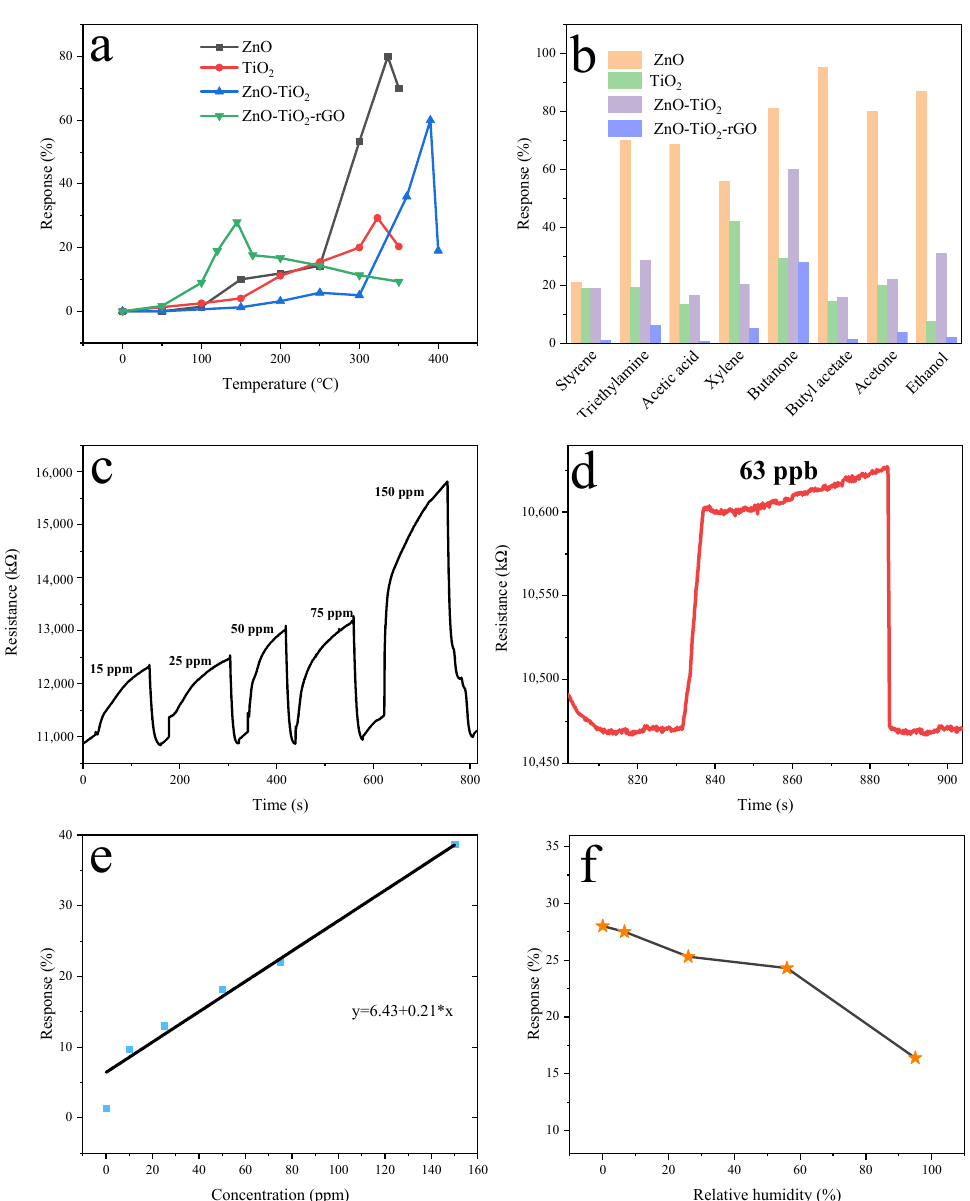
Figure 8. ( a ) Optimal operating temperatures for ZnO, TiO 2 , ZnO-TiO 2 , and ZnO-TiO 2 -rGO sensors. ( b ) Response of ZnO, TiO 2 , ZnO-TiO 2 , and ZnO-TiO 2 -rGO sensors to different gases at 100 ppm. ( c ) ZnO-TiO 2 -rGO sensor response versus butanone concentration. ( d ) Minimum lower limit of ZnO-TiO 2 -rGO sensor. ( e ) The sensitivity-fitting curves of ZnO-TiO 2 -rGO for different concentrations of butanone. ( f ) Humidity curve of the ZnO-TiO 2 -rGO sensor.